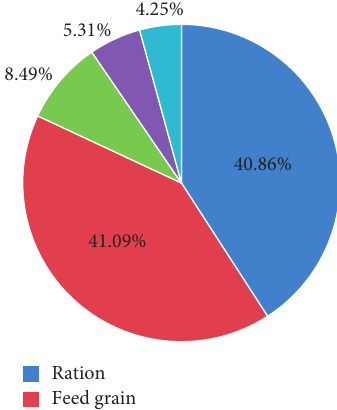
Figure 1: The proportion of China’s grain consumption by cat- egory in